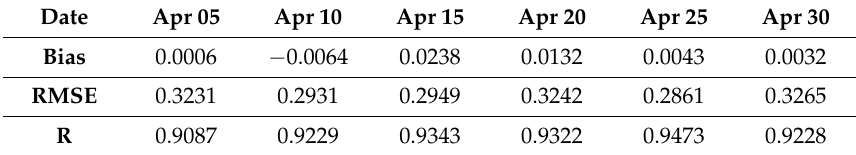
Figure 12. Distribution of mirror point trajectories for buoy stations and CYGNSS observations.